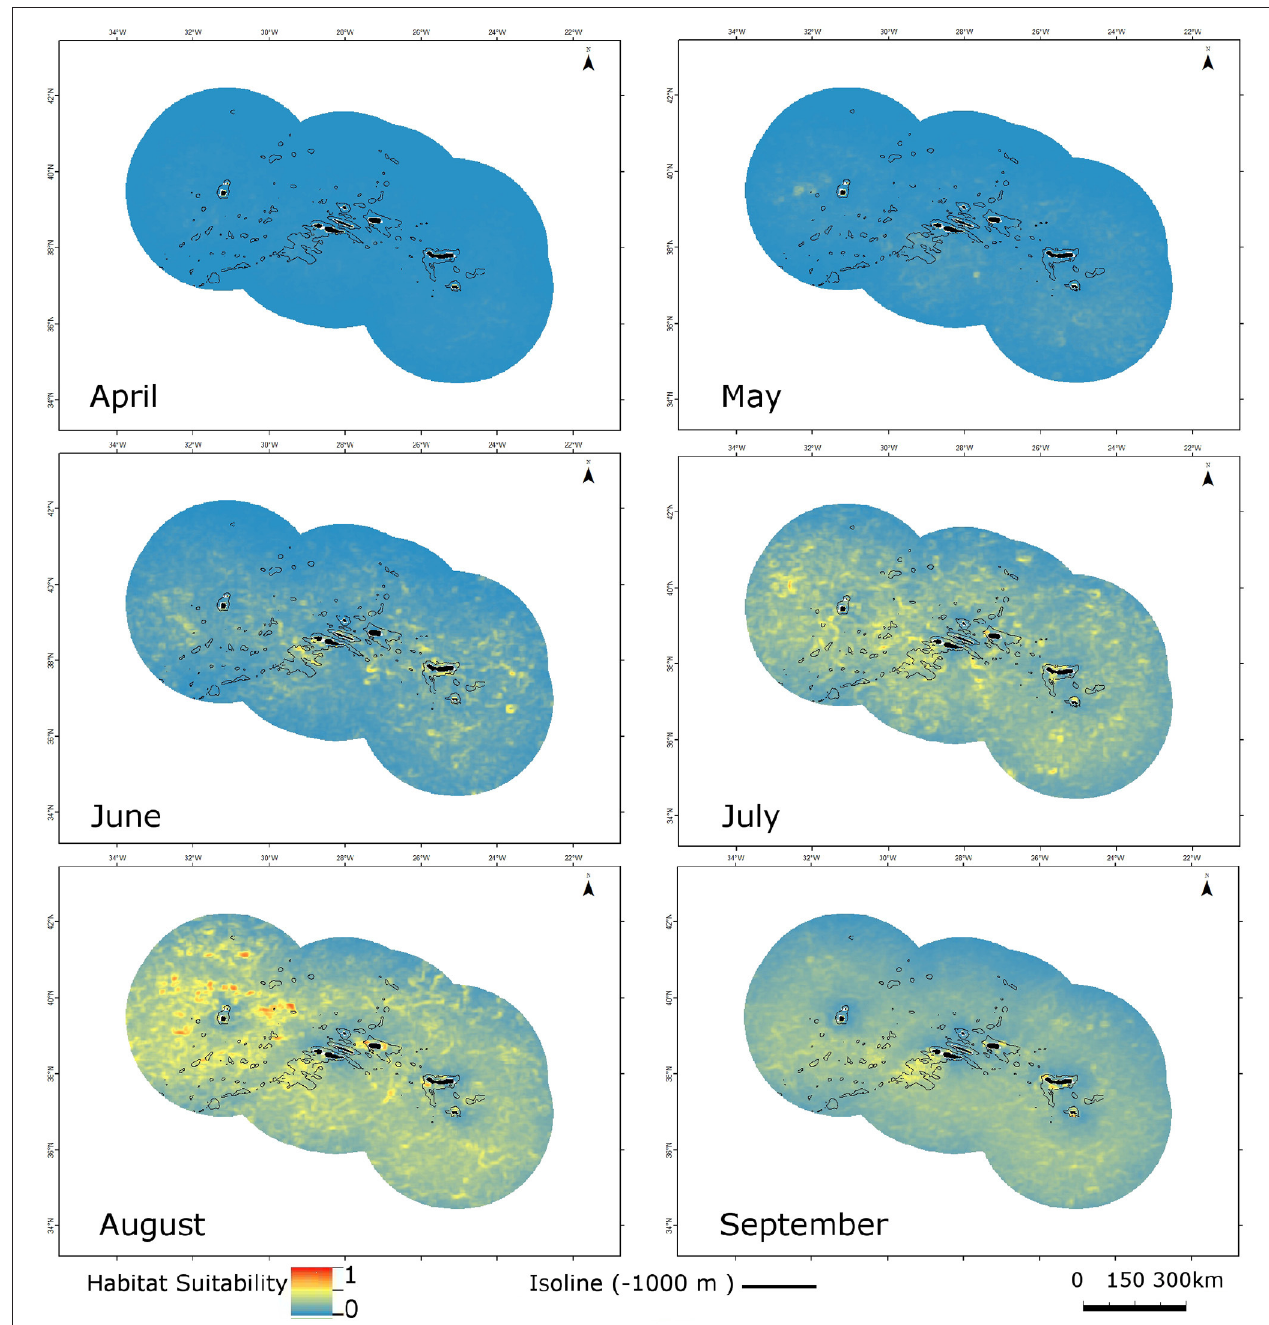
FIGURE 2 | Monthly potential distribution (April-September) of the Atlantic spotted dolphin ( Stenella frontalis ), from MaxEnt modeled habitat suitability. Warmer colors correspond to increased habitat suitability. The 1000m isoline is indicated by the thin black